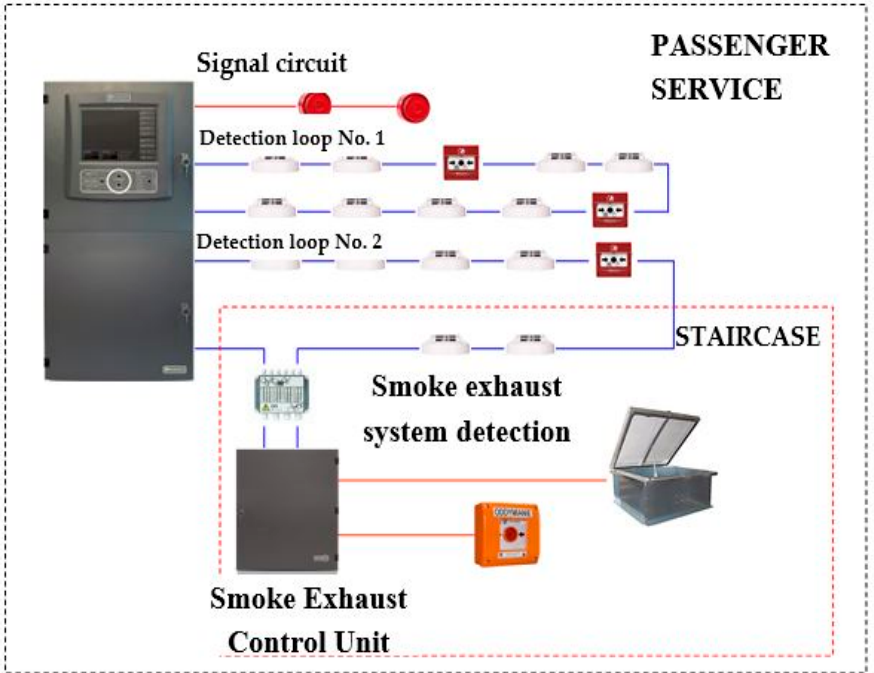
Figure 6. A selected fire alarm system located in the CI building, cooperating with the smoke exhaust control unit. Fire is detected by sensor connected to FAS detection loop No. 2 is the smoke exhaust system detection section (zone or group).